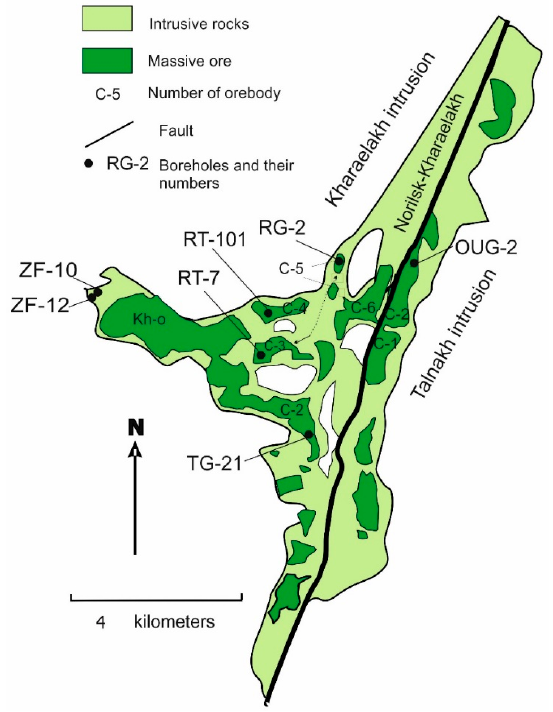
Figure 3. Projection of intrusive rocks and massive orebodies on the horizontal plane (according to blue and green contours in Figure 2) (after Norilskgeology Ltd. data, with changes).